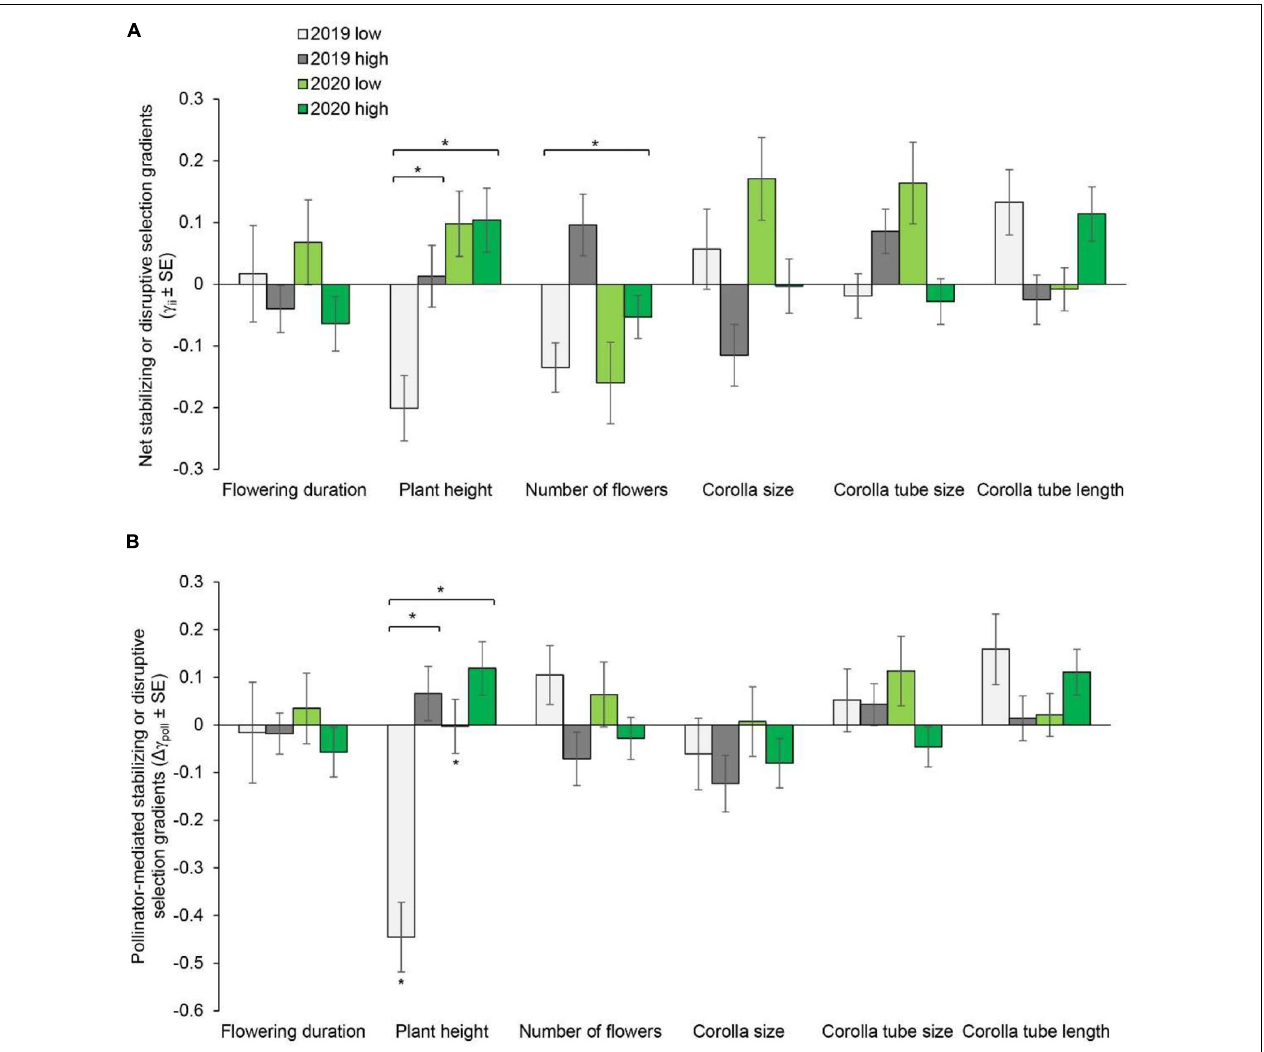
FIGURE 2 | Net stabilizing or disruptive selection gradients (A) and pollinator-mediated selection gradients (B) on flowering duration, plant height, number of flowers, corolla size, and corolla tube size and length in Primula tibetica at two sites (low and high soil water content sites). The symbols above the individual bars indicate the level of significance of the selection gradient. Symbols above the short lines spanning two gradients show whether ANCOVA indicated significant variation between sites in each year. Symbols above the long lines spanning several gradients show whether ANCOVA indicated significant variation between years. * P <